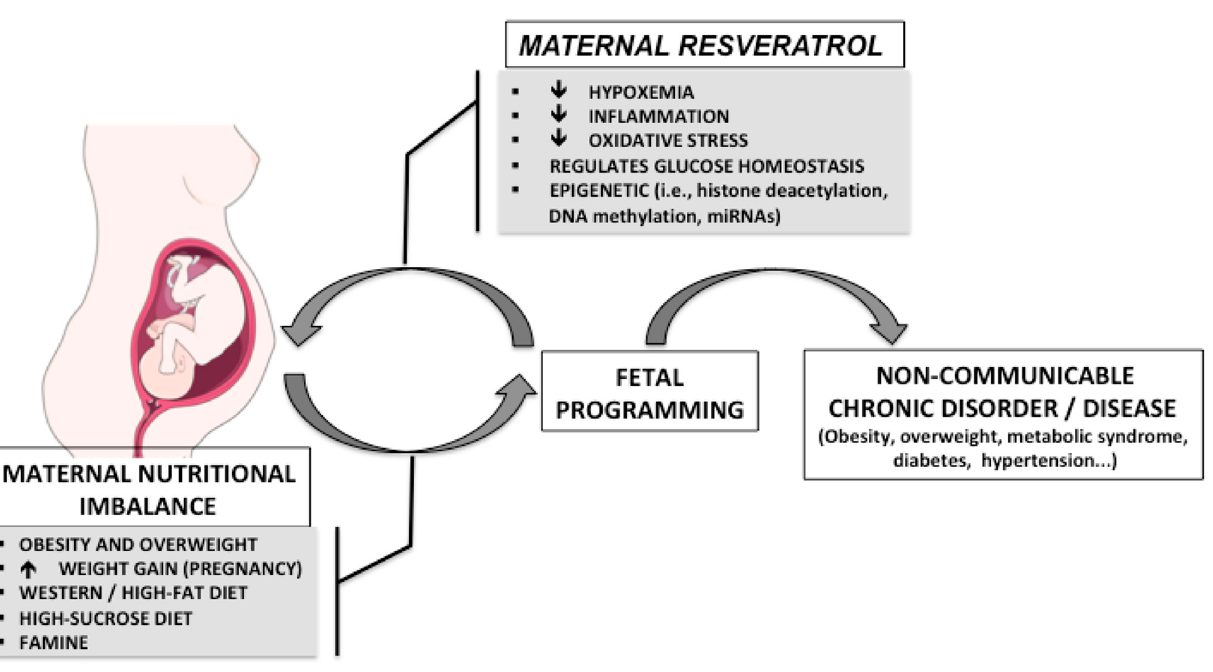
Figure 1. Possible programming effects of maternal nutritional imbalance during fetal and perinatal life and the potential beneficial effects of resveratrol.